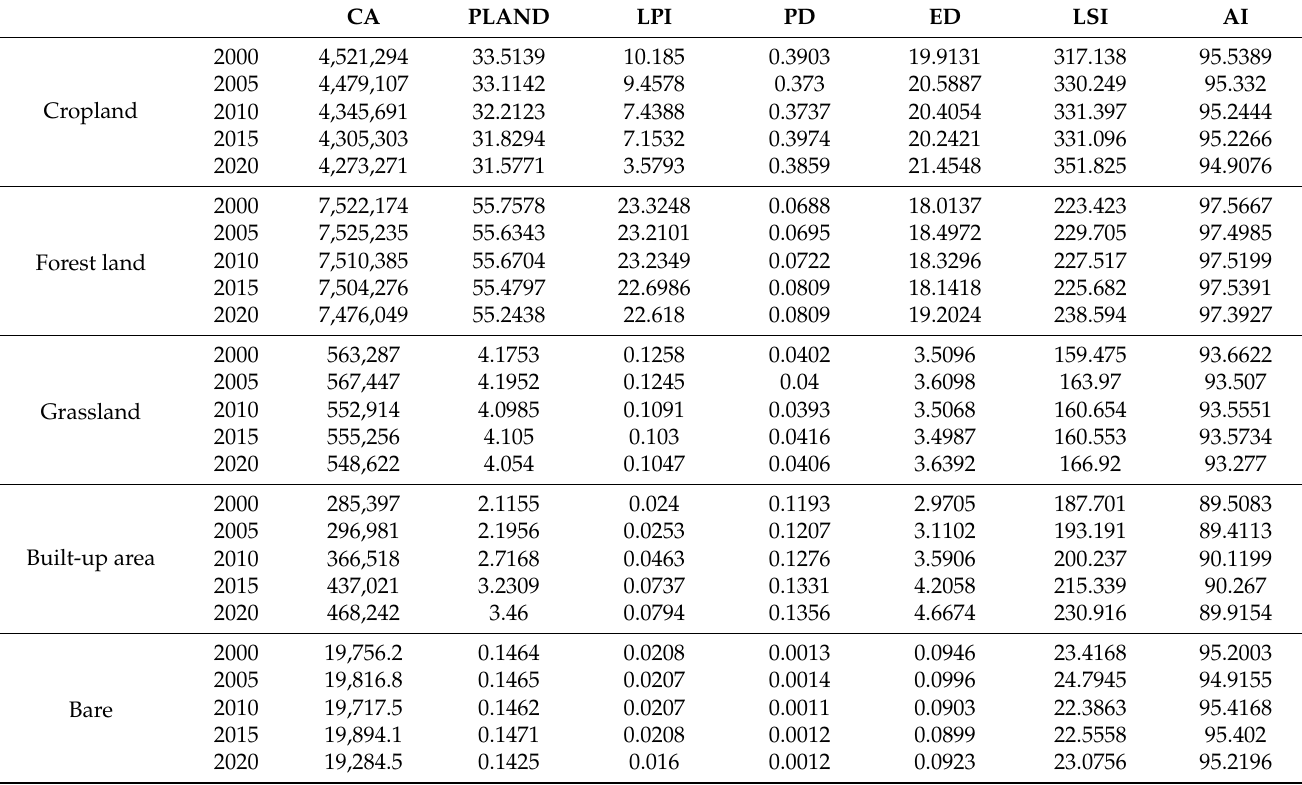
Table A2. Landscape pattern index analysis for each land use cover